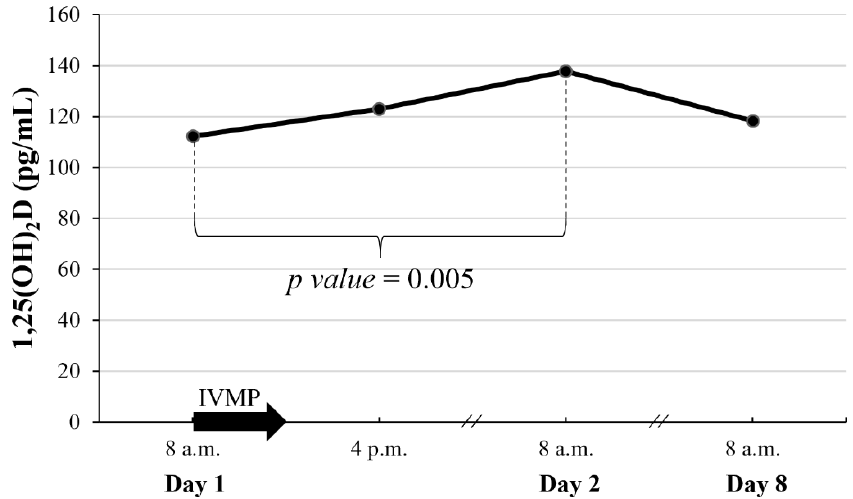
Figure 5. Early changes in calcium metabolism parameters after a single pulse of 0.5 g IVMP. * p value < 0.05 vs. baseline; ** p value < 0.01 vs. baseline; *** p value < 0.001 vs. baseline. The black arrow represents IVMP pulse of 0.5 g; IVMP intravenous methylprednisolone; TmP/GFR, tubular maximum reabsorption of phosphate adjusted to GFR; FeCa, fractional excretion of calcium.